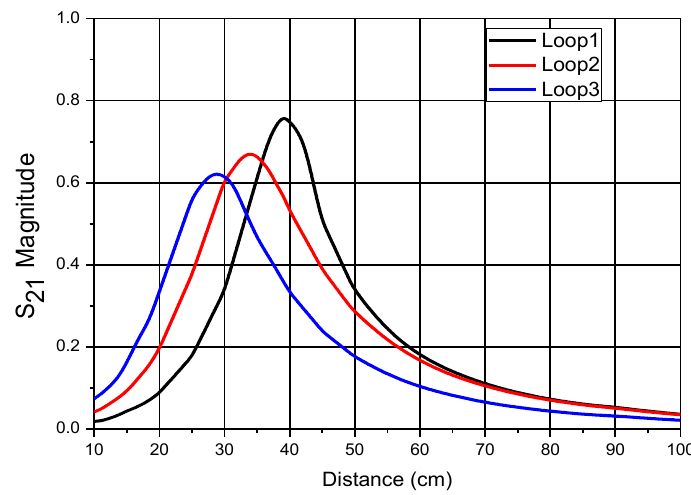
Figure 7. Simulated S 21 magnitude for different loops with varying d 23 in the Case 1 system.